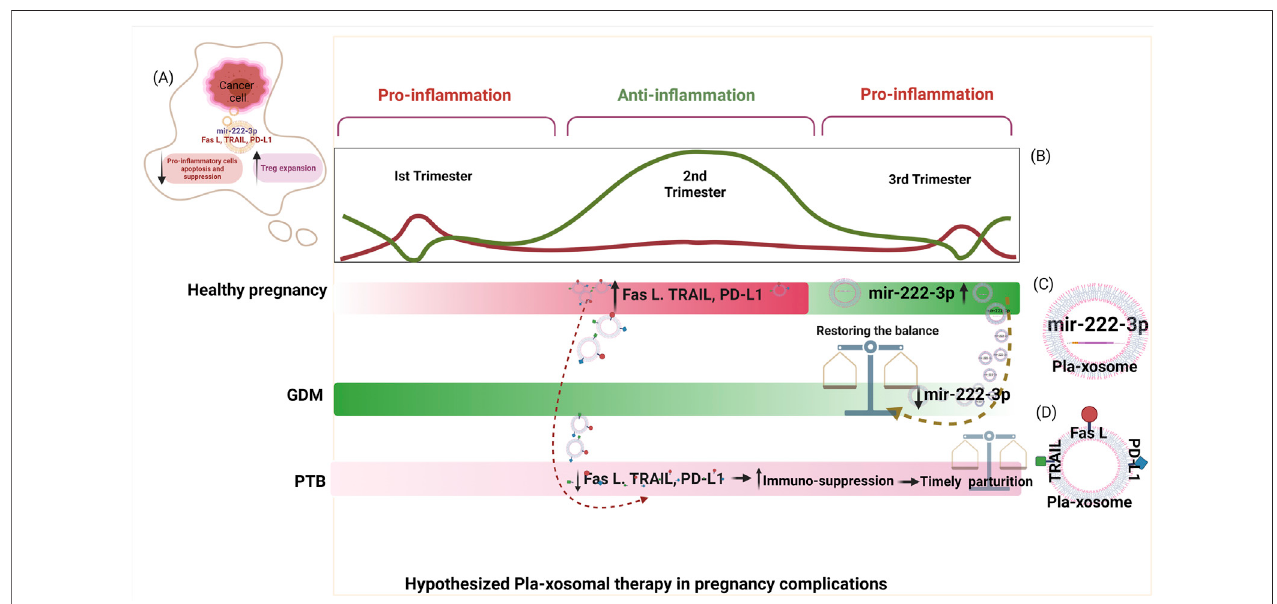
FIGURE 6 | Hypothesized pla-xosomal therapy for pregnancy complications: Taking lessons from cancer (A) Cancer cells derived exosomes contain mir-222-3p, PD-L1, Fas L, and TRAIL that cause suppression of pro-in fl ammatory cells and expansion of anti-in fl ammatory cells (Tregs) (B) Balanced pro-and anti-in fl ammatory milieu in a healthy pregnancy with increased expression of PD-L1, Fas L, TRAIL in second Trimester and mir-222-3p in third Trimester (C) Pla-xosome containing mir- 223: postulated therapy for GDM (D) Pla-xosome containing PD-L1, Fas, TRAIL: postulated therapy for PTB. Dotted lines represent the donor and recipient gestational windows of plax-osomes